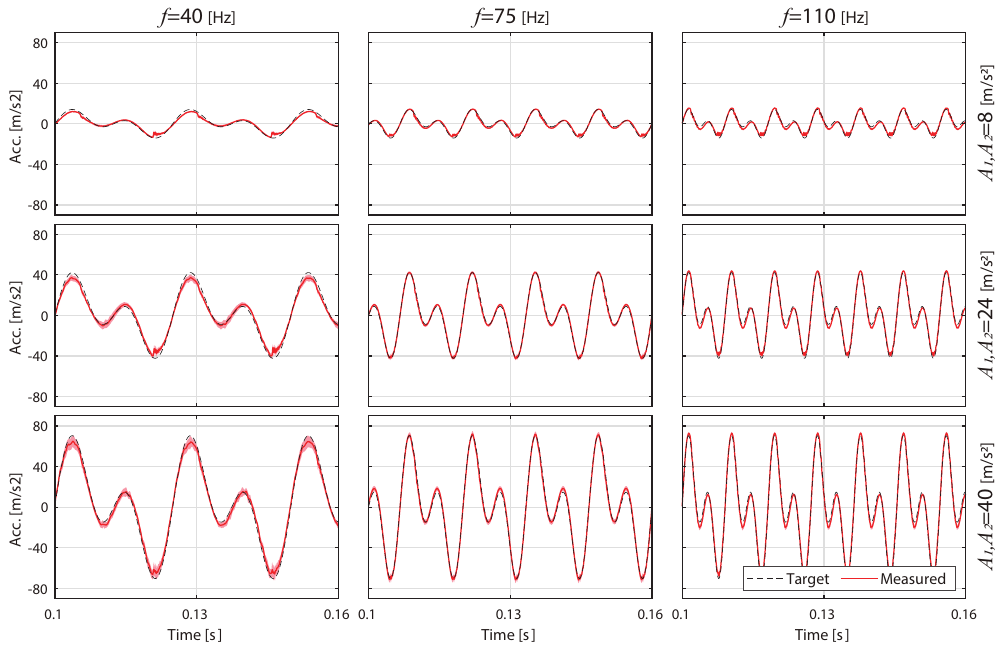
Figure 6. Typical example of an acceleration profile of the fingertips (in Equation (1), f = 40, 75, 110 Hz, φ 0 = 0 deg, A 1 = A 2 = 8, 24, 40 m/s 2